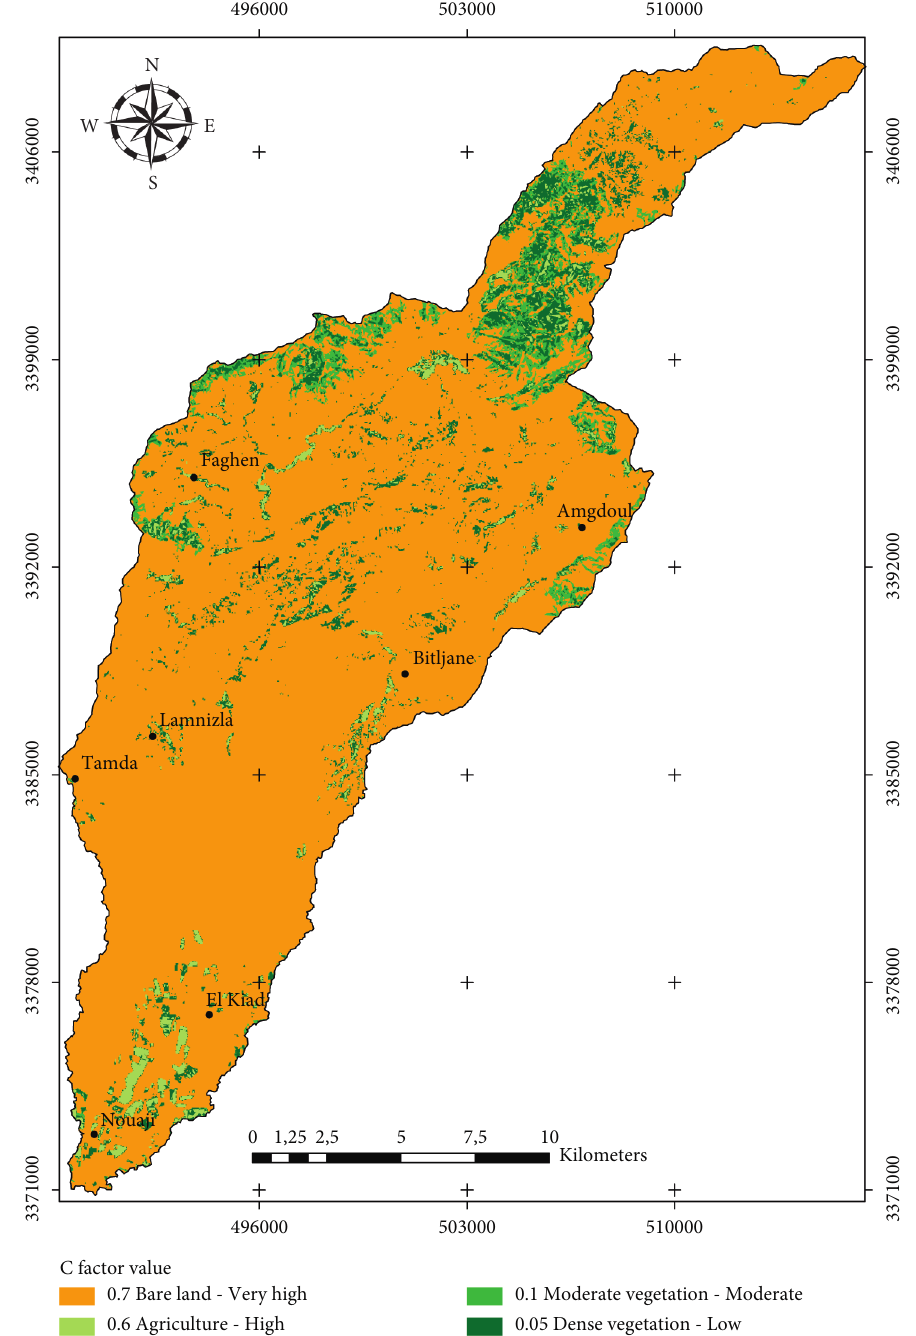
Figure 7: Spatial distribution of vegetation coverage factor (C) at Beni Mohand River